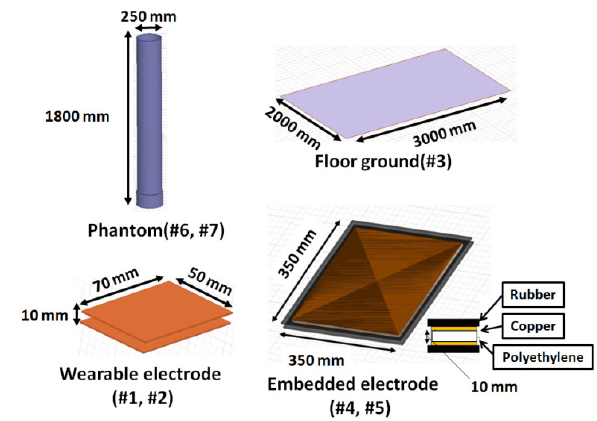
Figure 9. Structures in electromagnetic field simulation.